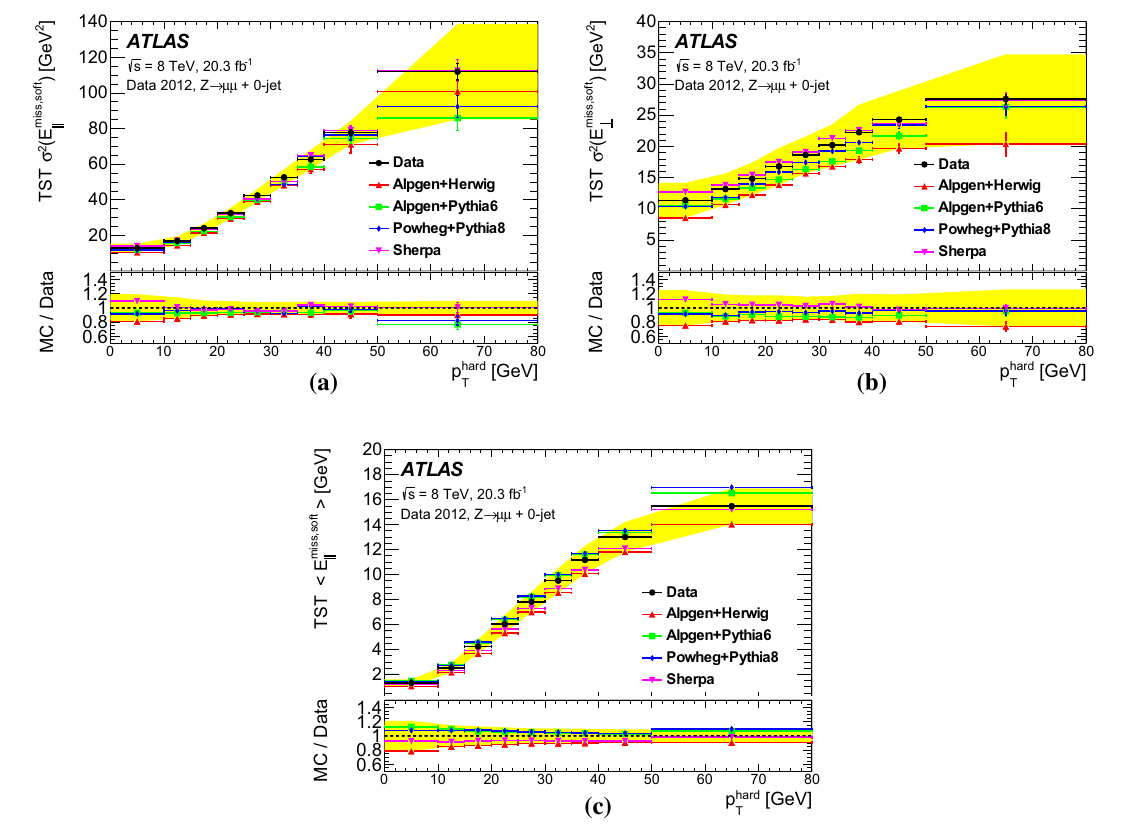
Fig. 23 The fitted TST a σ 2 ( E miss , soft (cid:10) ) , b σ 2 ( E miss , soft ⊥ ) , and c errors from the Gaussian fits. The solid band , which is centred on the data, shows the parameter’s systematic uncertainties from Table 6. The (cid:5) in each case versus p hard (cid:4) E miss , soft are shown in data and Alpgen + (cid:10) T insets at the bottom of the figures show the ratios of the MC predictions Herwig , Powheg + P ythia8 , Sherpa ,and Alpgen + Pythia Z → μμ to the data simulation. The error bars on the data and MC simulation points are the